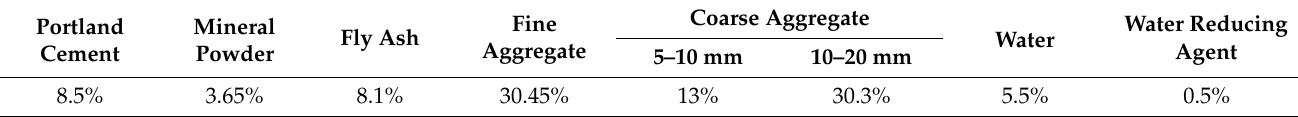
Table 1. Mixture proportion of the C40